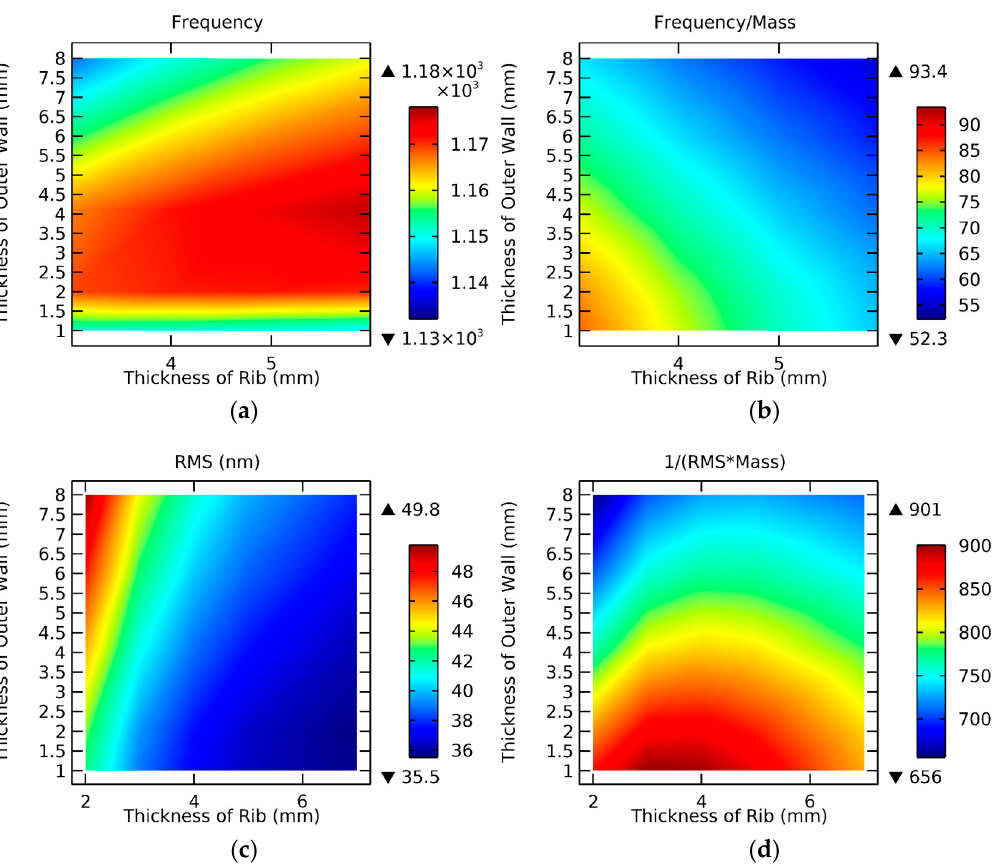
Figure 7. Performance analysis of the thickness of the rib and outer wall under different parameters. ( a ) Frequency; ( b ) Frequency/Mass; ( c ) RMS; ( d ) 1/(RMS*Mass).